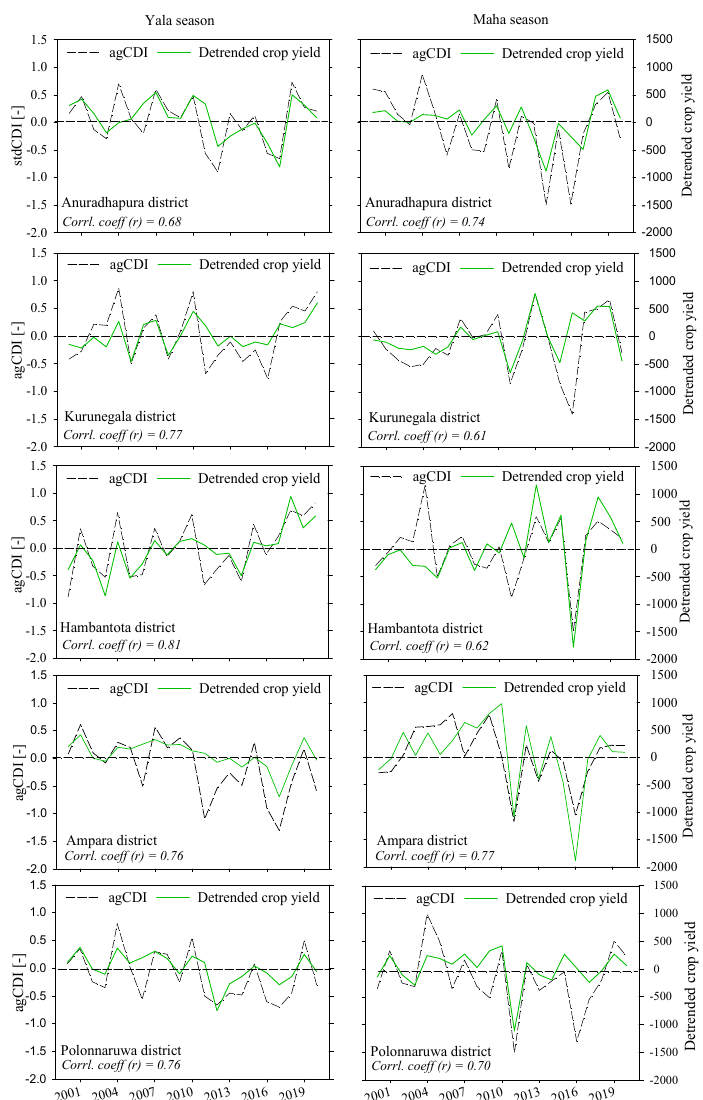
Figure 10. Evaluation of agCDI with detrended crop yield for the selected crop growing districts for the Yala and Maha seasons. the Yala and Maha